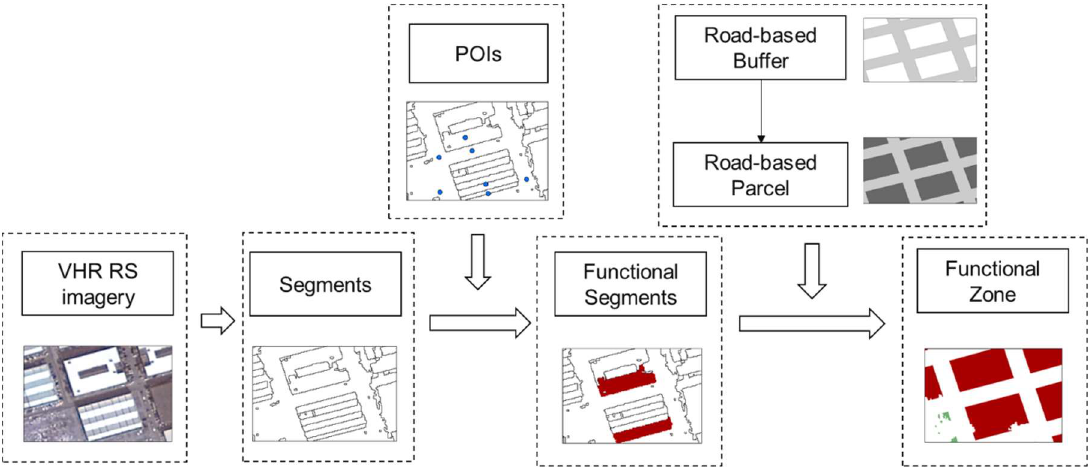
Figure 1. The workflow of mapping functional zones.